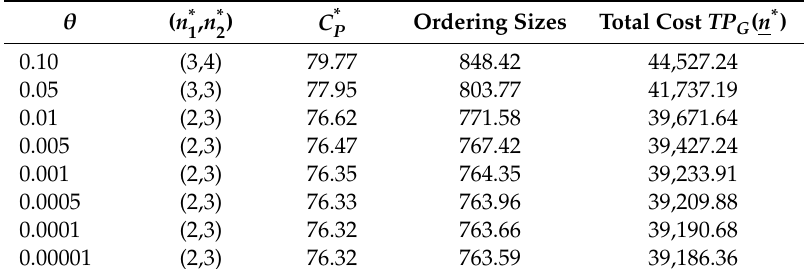
Table 4. Optimal solutions for various deterioration rates.